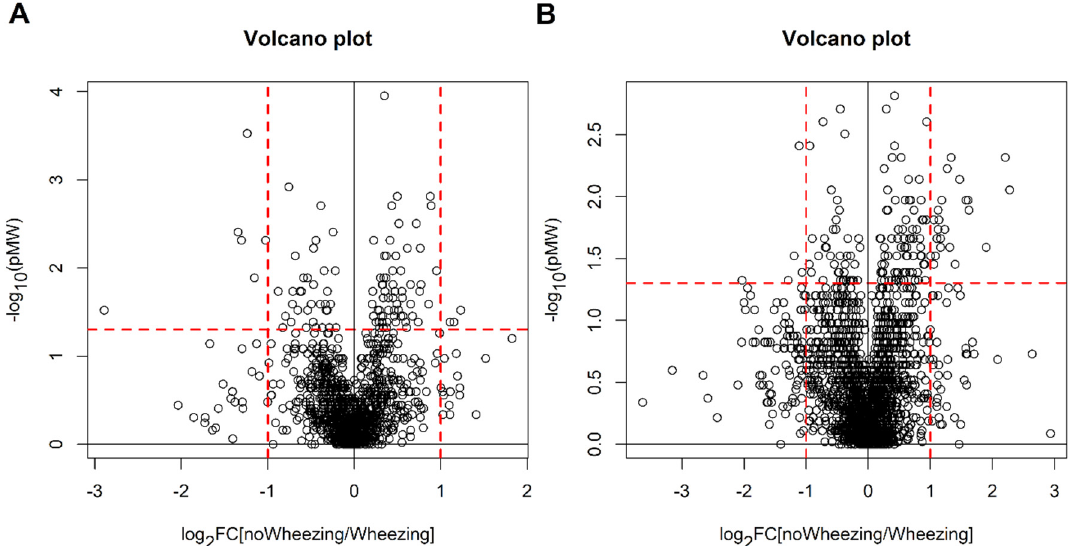
Figure 4. Children with bronchiolitis with or without recurrent wheezing: Volcano plots obtained for the POS dataset (panel ( A )) and for the NEG dataset (panel ( B )); the dashed red lines indicate the limits of p Mann-Whitney (pMW) equal to 0.05 and |log 2 FC| = 1. Table 2. Risk factors distribution in children according to the development of recurrent wheezing in the no-bronchiolitis